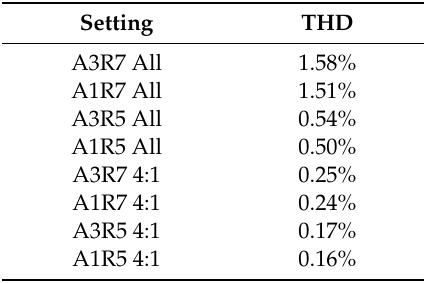
Table 4. THD measurements made using a 1 kHz tone and the time constants and ratios used in Listening Experiment